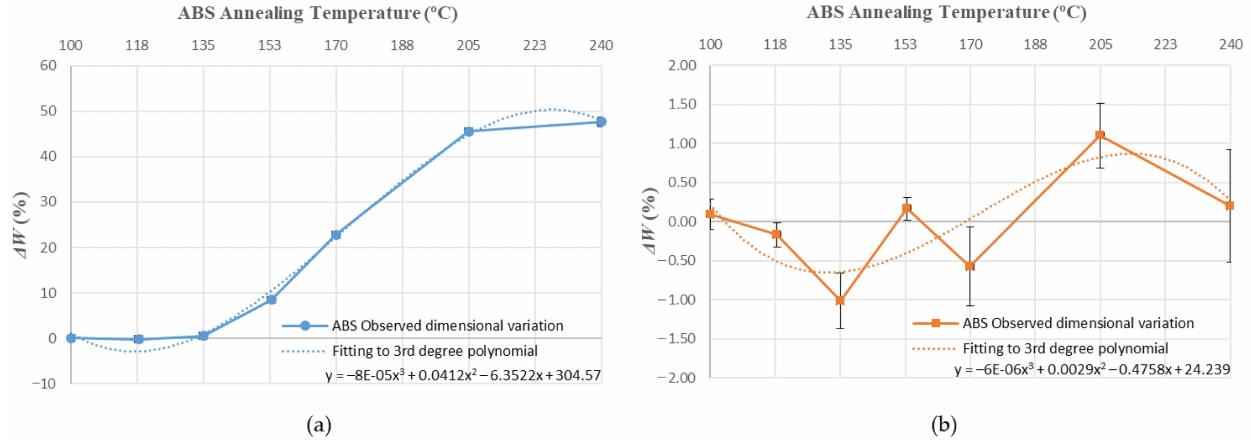
Figure 12. ABS width variation vs. annealing temperature third-degree polynomial approximation: ( a ) without mould; ( b ) with